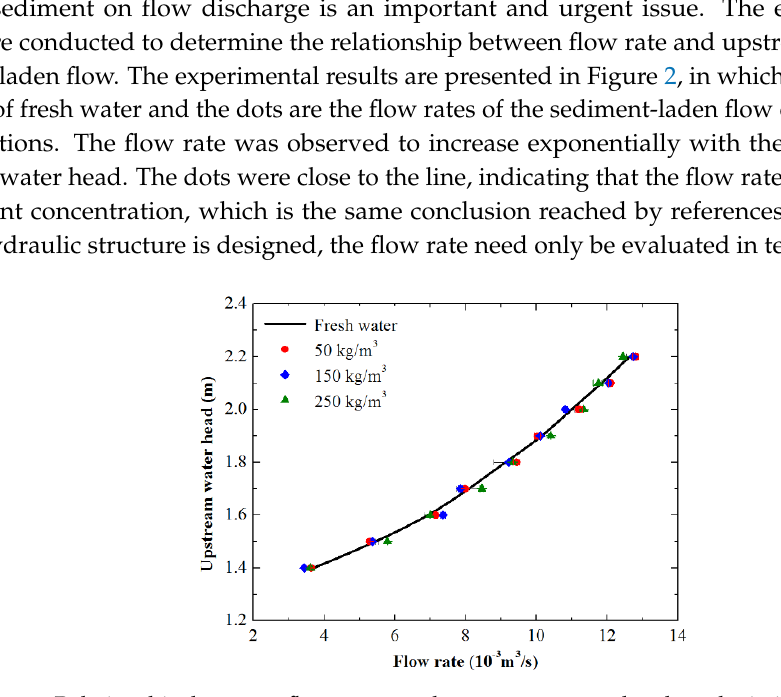
Figure 2. Relationship between flow rates and upstream water head to deviations at different sediment concentrations.